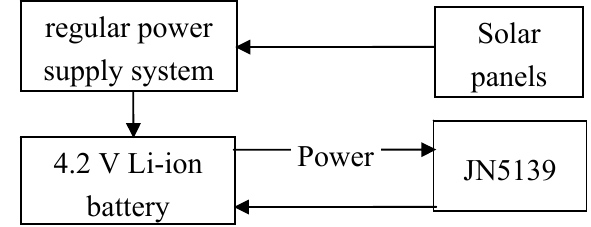
Figure 6. The composition of the node power management system.